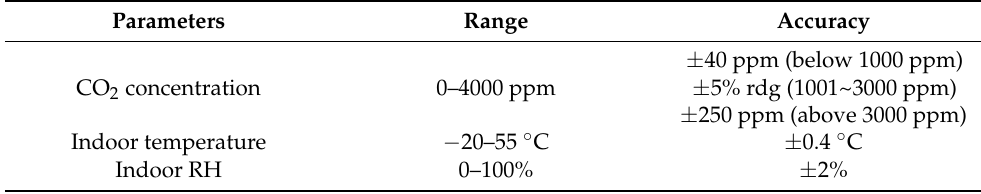
Table 1. Summary of instrument range and